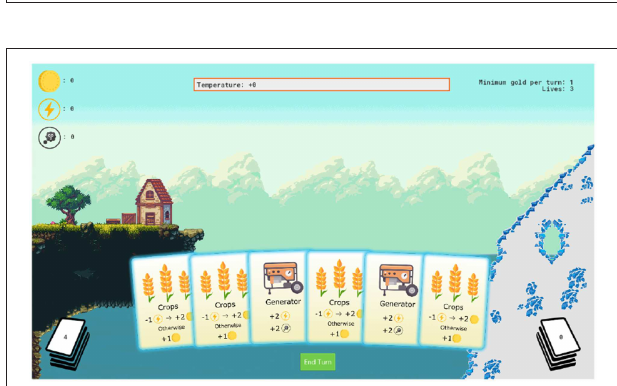
FIGURE 3 | Screen shot from Isorropia showing the available structures for the player to buy ( Return Null, 2018).